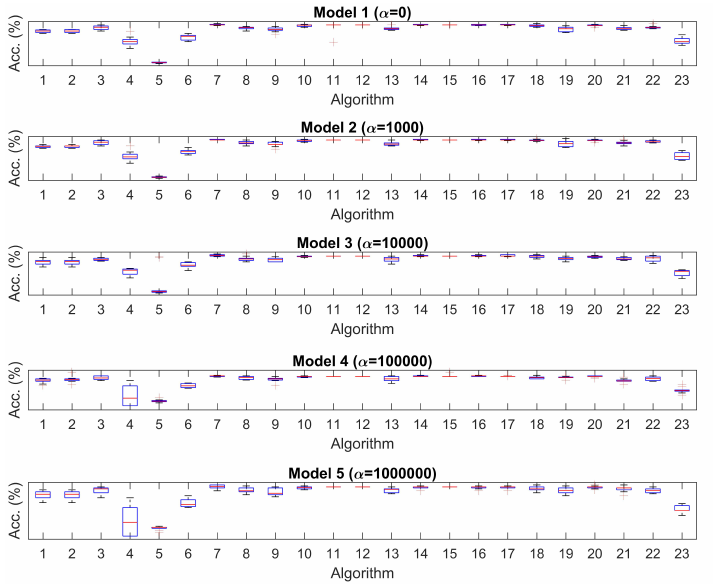
Figure 4. Numerical simulation Assumption 1. Accuracy of models after increasing the translation constant α for all the 23 algorithms. The 23 algorithms are represented in the x -axis, and the accuracy is shown in the y